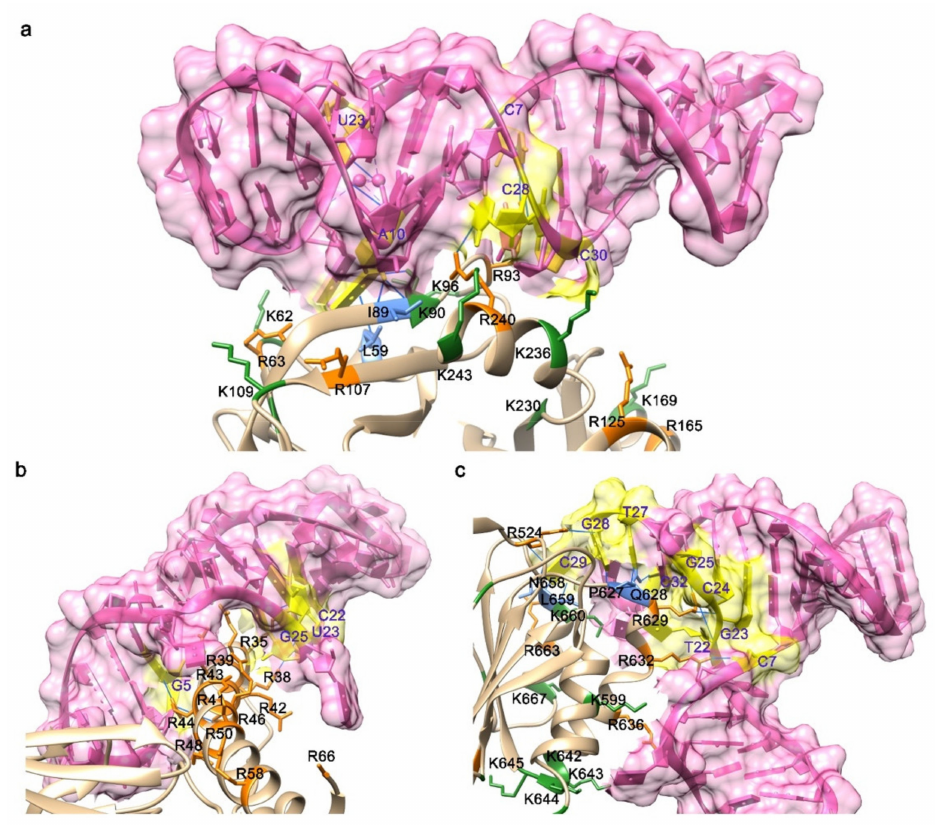
Figure 2. Interfaces of the aptamer–protein complexes exhibited common features of interaction. ( a ) The interface of the X-ray crystal structures of the RNA aptamer 11F7t bound to GD-FXaS195A (PDB ID: 5voe). ( b ) The interface of a potential anti-HIV-1 RNA aptamer in complex with Rev93: scFv (PDB ID: 6cf2). ( c ) The interface of the DNA aptamer ARC1172 in complex with VWF A1 domain (PDB ID: 3hxq). All aptamers were shown in pink, and the hydrogen bond was (blue solid lines) found between nucleotides (shown in yellow and labeled in blue) in the aptamer and residues on the proteins. The involved residues were mainly positive charged residues, including Lys (shown in green and labeled in black) and Arg (shown in orange and labeled in black). Other residues were non-charged residues (shown in green and labeled in black), including Leu, Ile, Pro and